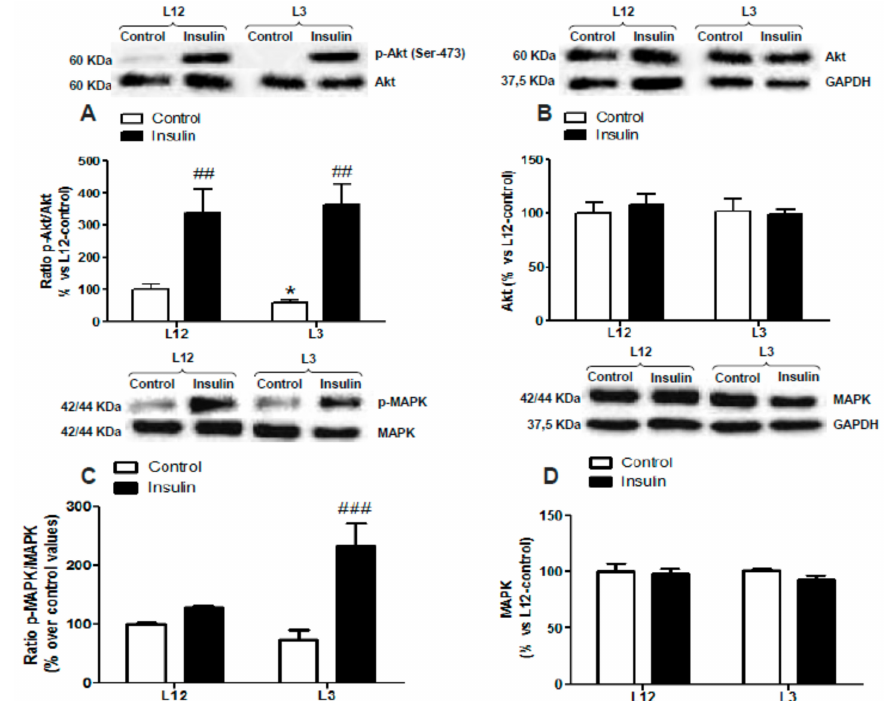
Figure 3. Protein levels of ( A ) ratio of phosphorylated to total Akt (p-Akt / Akt), ( B ) total Akt (Akt), ( C ) ratio of phosphorylated to total mitogen-activated protein kinase (MAPK) (p-MAPK / MAPK), and ( D ) total MAPK (MAPK) in perfused hearts from rats raised in L12 or L3 litters, incubated either with vehicle (control) or with insulin (10 − 7 M) for 30 min. Note: * p < 0.05 di ff erence between control hearts from L3 and L12; ## p < 0.01; ### p < 0.001 di ff erence between hearts incubated with insulin and control. Values are represented as mean ± SEM ( n = 4–5 rats / experimental group) and expressed as % vs. L12. Data were analyzed by two-way ANOVA followed by Bonferroni post-hoc